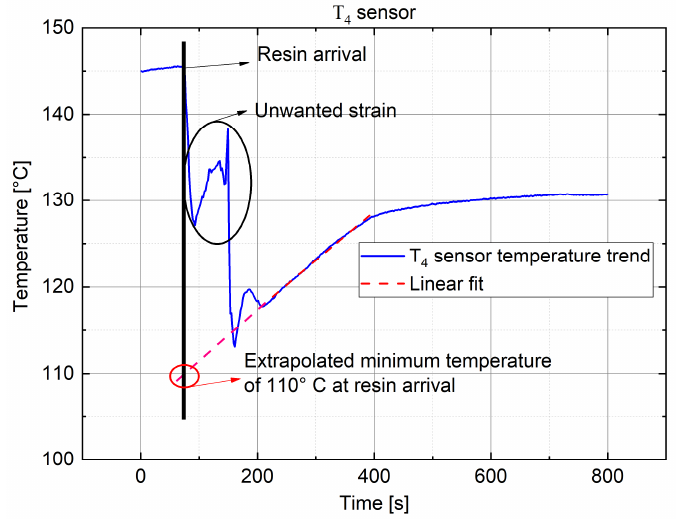
Figure 15. Temperature variation measured with FBG sensor T4 with an extrapolation to obtain the